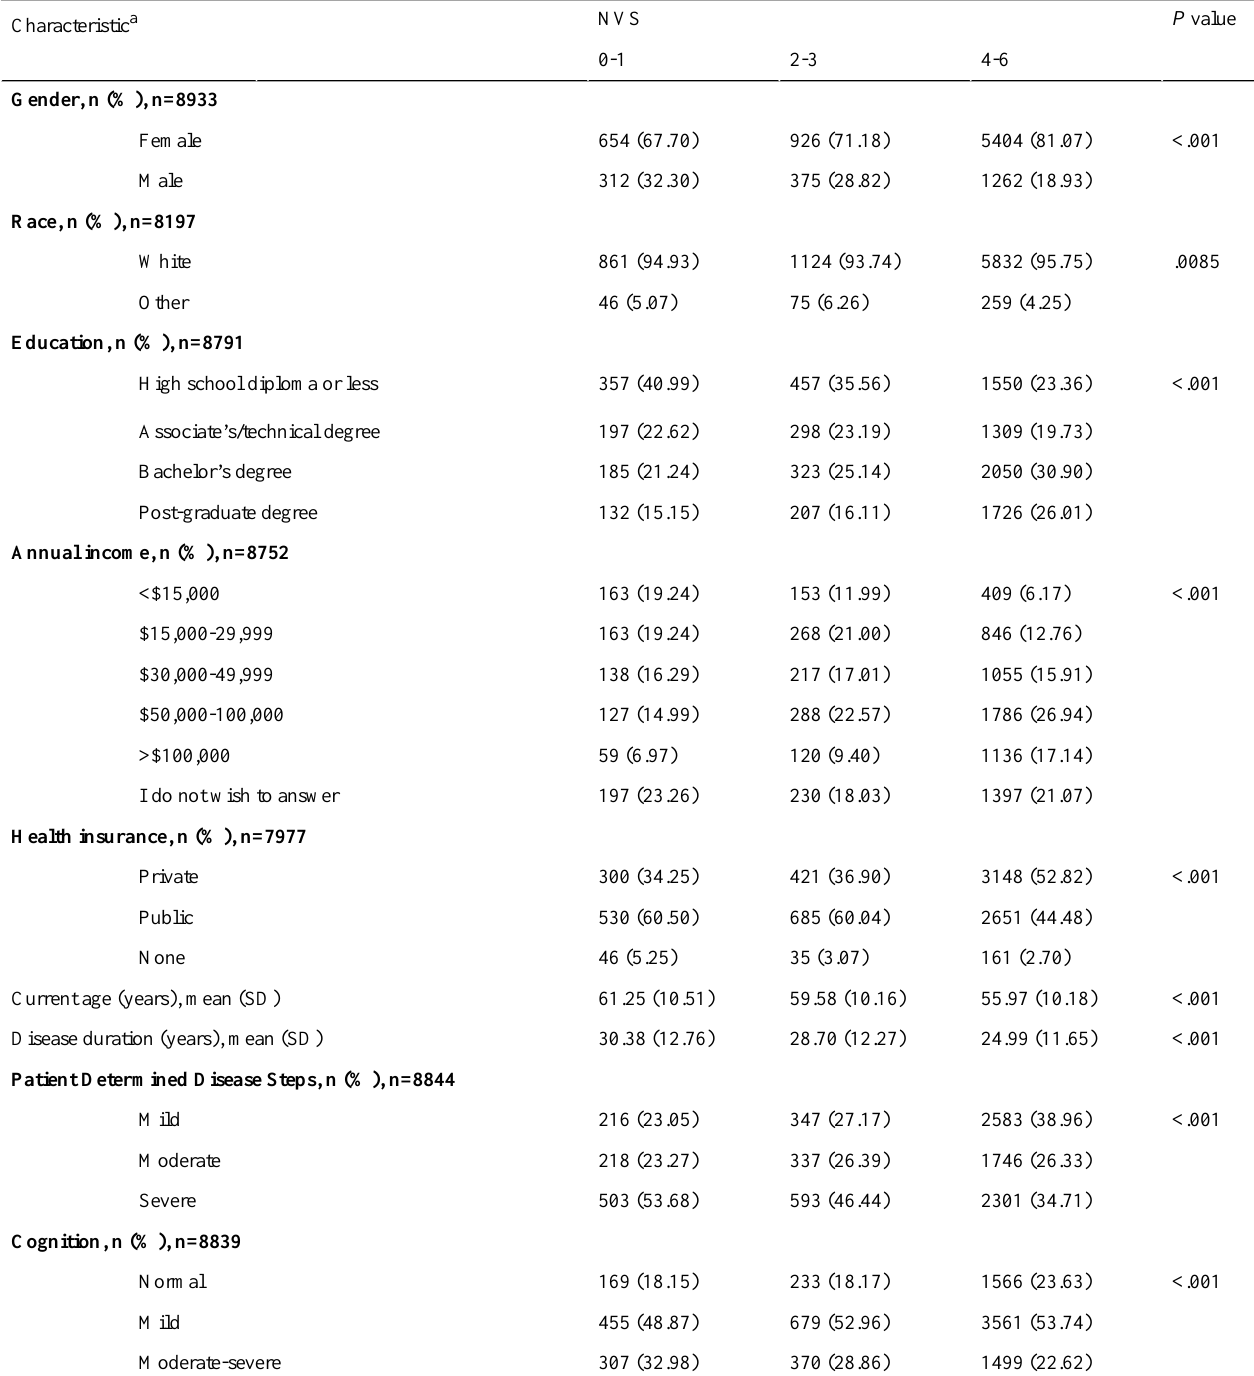
Table 3. Univariate associations between participant characteristics and health literacy as measured by the Newest Vital Sign (NVS).